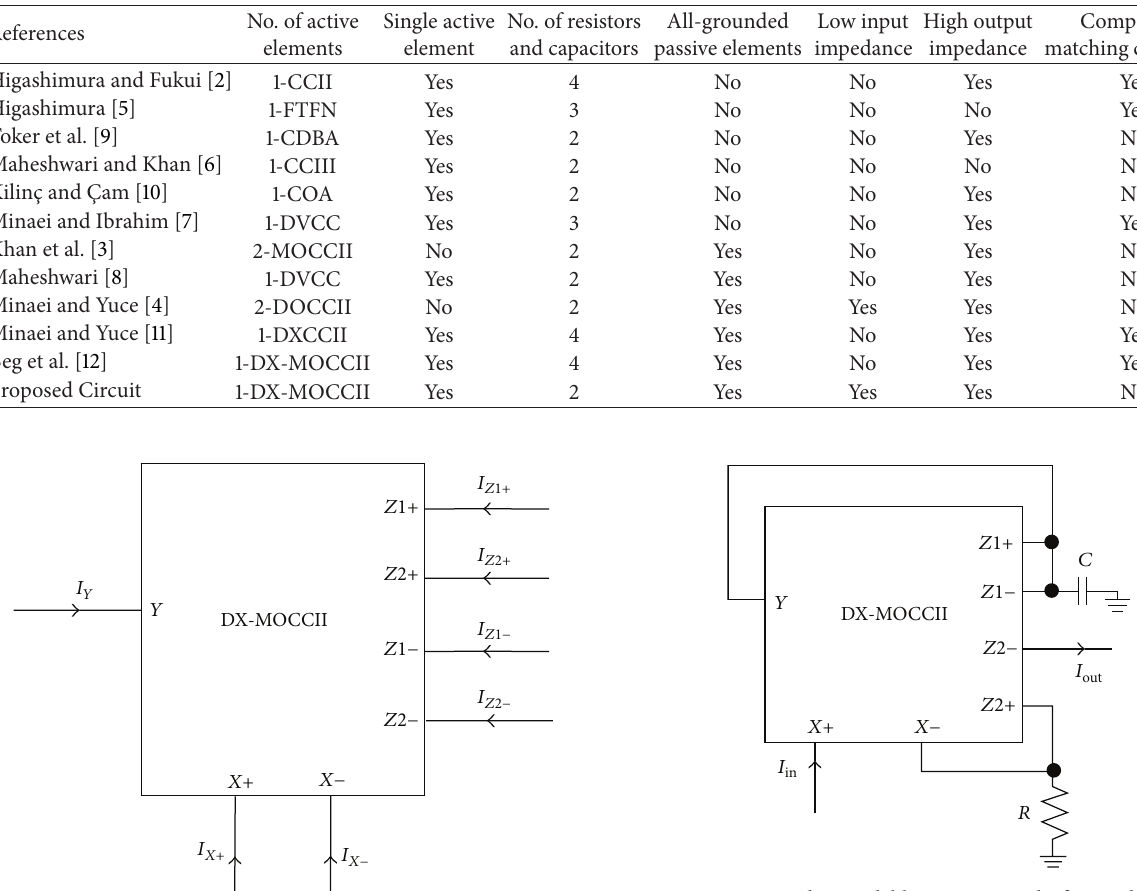
Figure 2: Proposed cascadable current-mode first-order all-pass